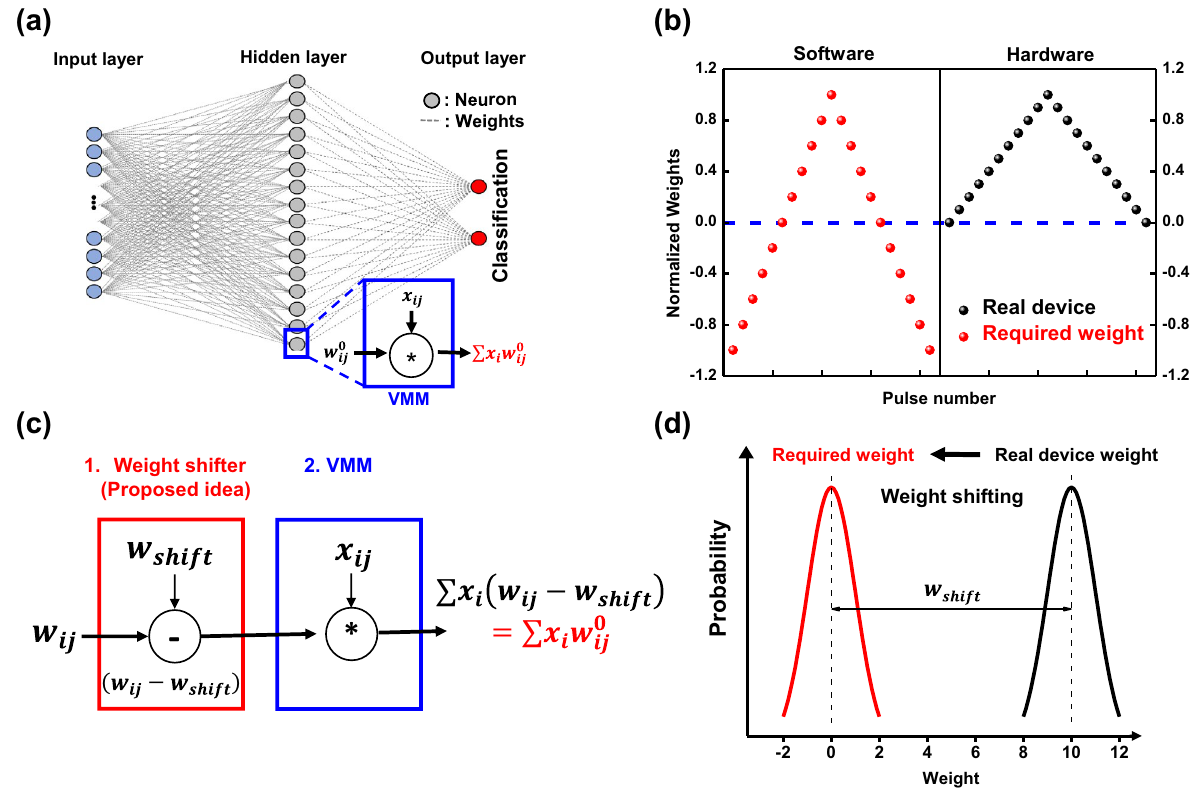
Figure 1. ( a ) Simple illustration of employed deep learning neural network (DNN) with the vector matrix multiplication (VMM). ( b ) Normalized required weight values in software based DNN (S-DNN), and weight values of real synapse device. Contrast to the S-DNN, the synapse device has only positive conductance values which is expressed as weight values. ( c ) Concept of proposed weight shifter to realize negative weight in the hardware based DNN (H-DNN). The positive conductance values of synapse device can be considered as positively shifted weight values. The difference between required weight values of the S-DNN and positively shifted weight values of the H-DNN (w shift ) can be subtracted during the VMM. ( d ) Distributions of weight values in the S-DNN and H-DNN. The w shift can be compensated by the weight shifter during